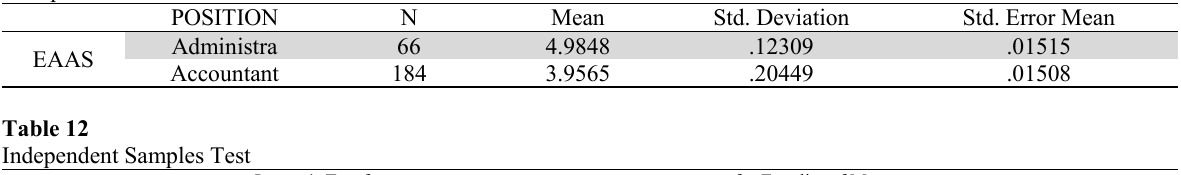
Levene's Test for Equality of Variances Sig.